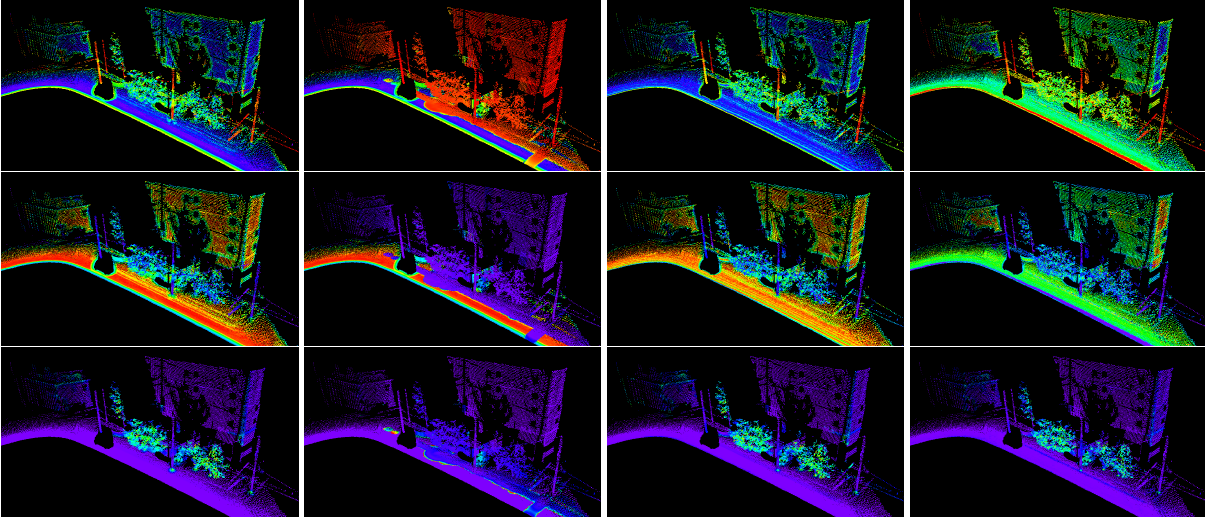
Figure 3. Behavior of the three dimensionality features of linearity L λ (top row), planarity P λ (center row) and sphericity S λ (bottom row) for the neighborhood types N s, 1m , N c, 1m , N k =50 and N k (from left to right): the color encoding indicates high values close opt to 1 in red and reaches via yellow, green, cyan and blue to violet for low values close to 0 .